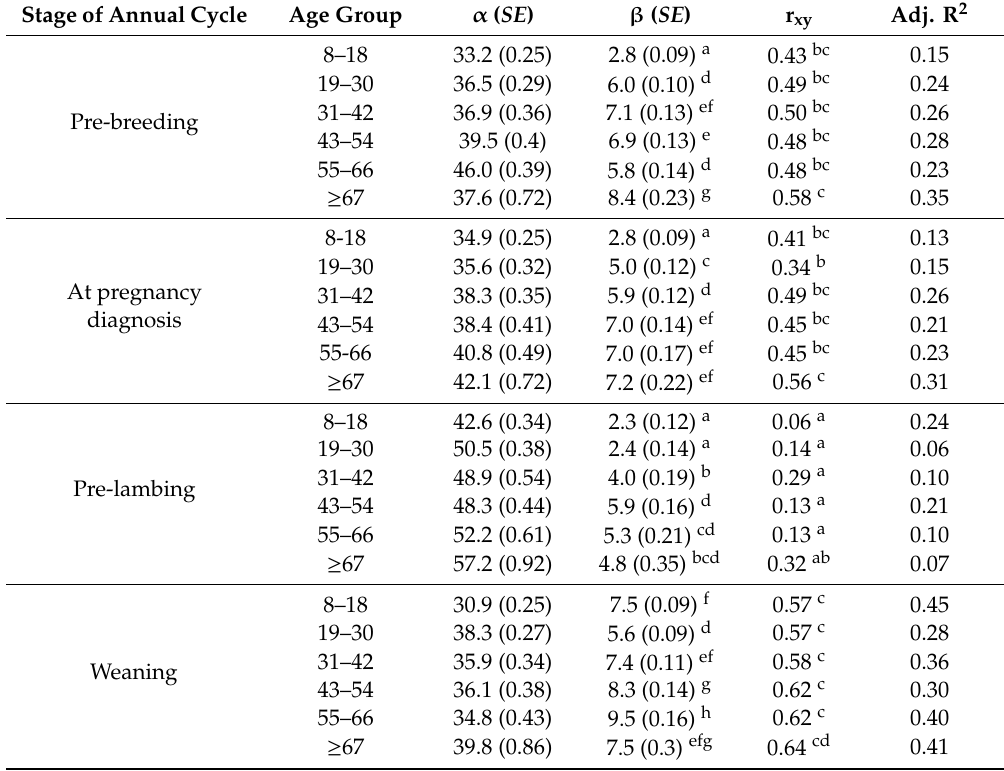
Table 4. Intercepts ( α ), coe ffi cients ( β ), correlation coe ffi cient (r xy ) and adjusted R 2 for the regression of the liveweight with body condition score for each stage of the annual cycle (pre-breeding, at pregnancy diagnosis, pre-lambing, weaning) and ewe age (8–18 months, 19–30, 31–42, 43–54, 55–66 and ≥ 67). Stage of Annual